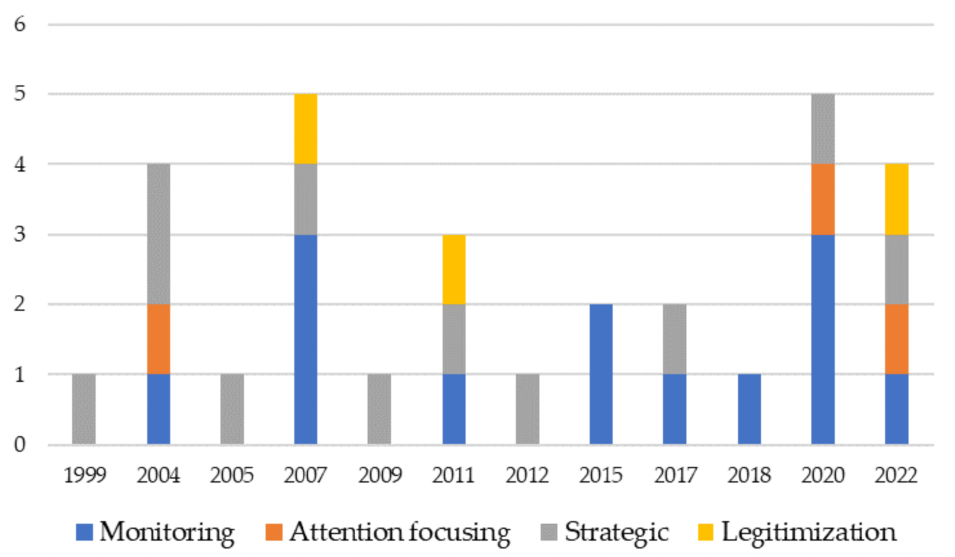
Figure 9. Distribution of papers by BSC use and